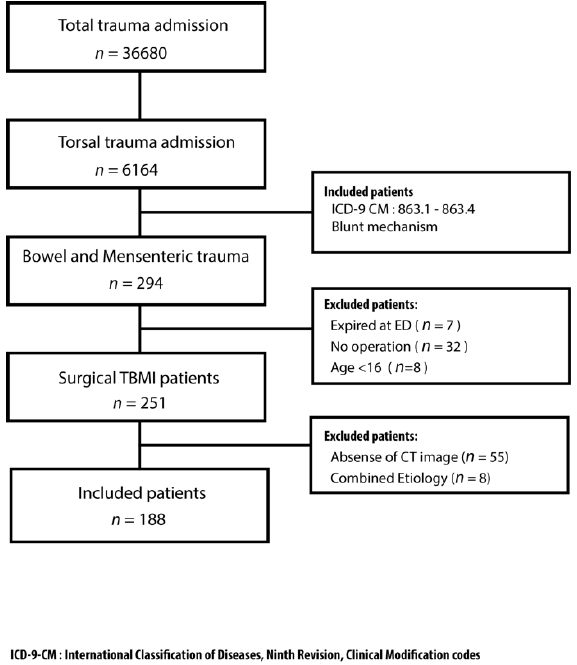
Figure 4. The flow chart of this study.